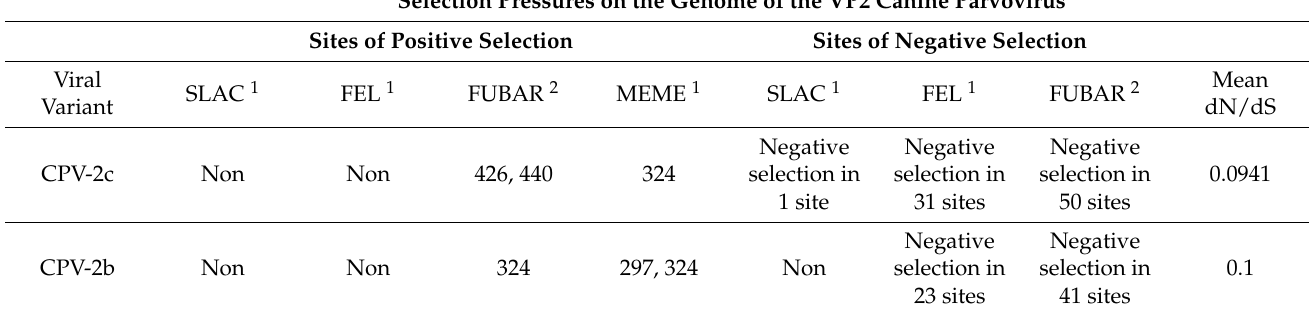
Table 2. Selection pressure on VP2 in the sequenced samples. Selection Pressures on the Genome of the VP2 Canine Parvovirus Sites of Negative Selection